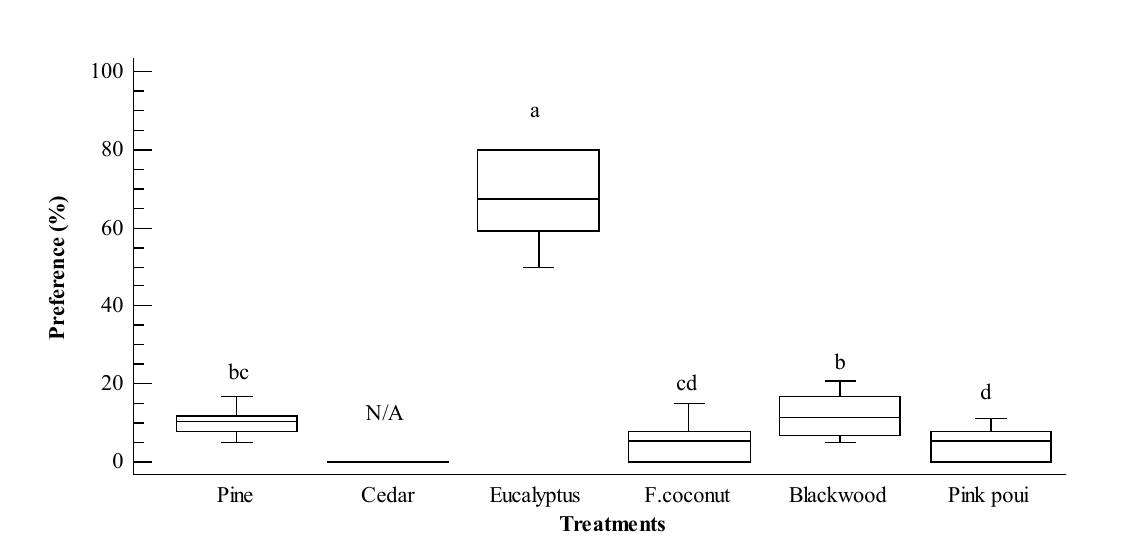
a Different lowercase letters within a row or different uppercase letters within a column indicate significant differences between Means.